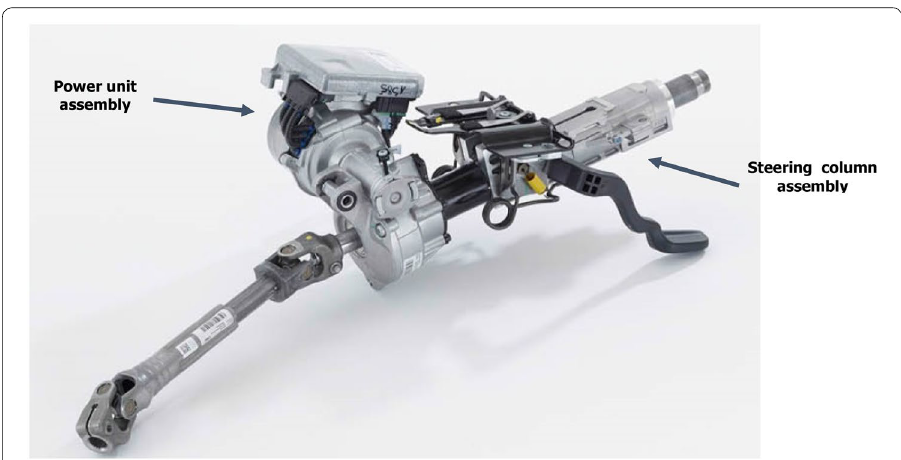
Fig. 1 Example EPS‑CD